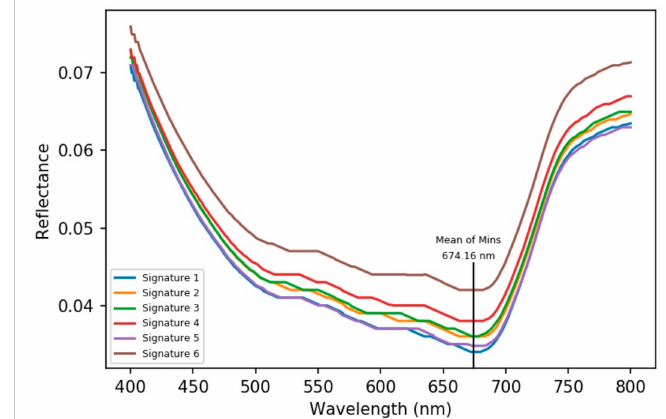
Figure 12. Di ff use skylight e ff ect within a shadow footprint that was cast by an occulter at 0 ◦ zenith and azimuth. The exponential decay behaviour of the di ff use skylight e ff ect within shadow ceases at 674.16 nm, the mean of minimum values from six reflectance signatures.